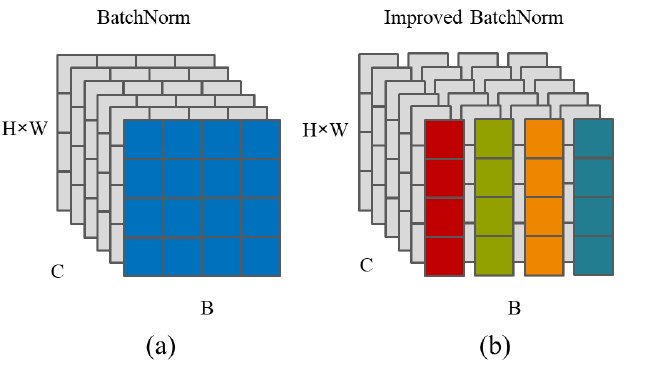
Figure 7. Improved batch normalization schematic diagram. ( a ) BatchNorm; ( b ) Improved BatchNorm.